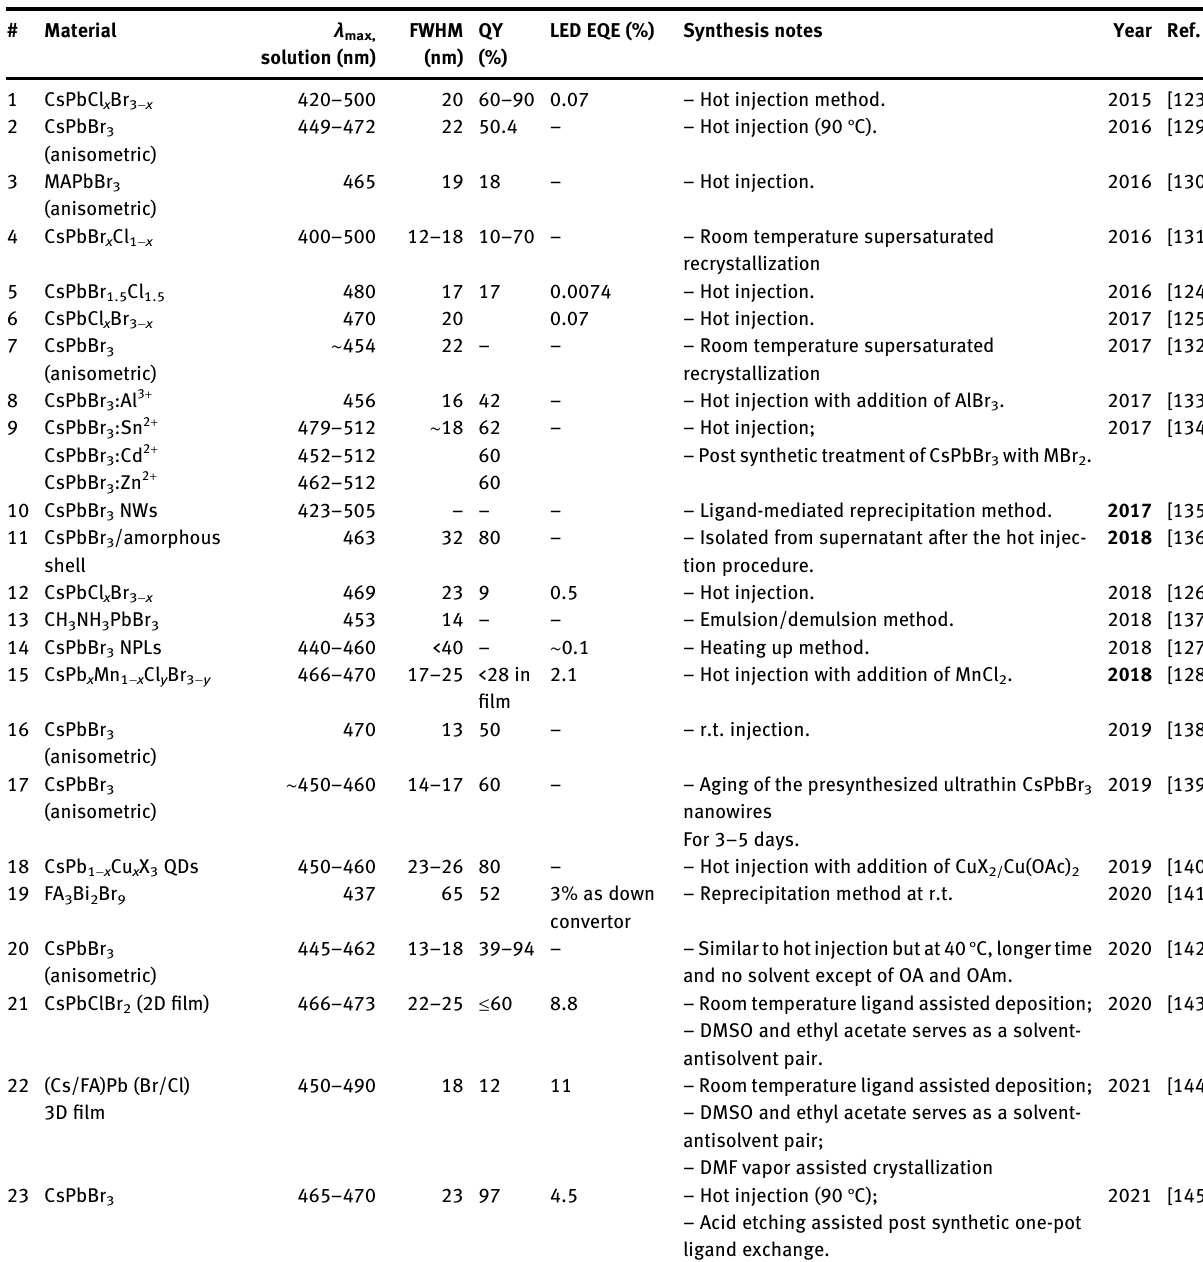
Table  : Blue-emitting perovskite nanoparticles, their PL/EL and synthetic features. #